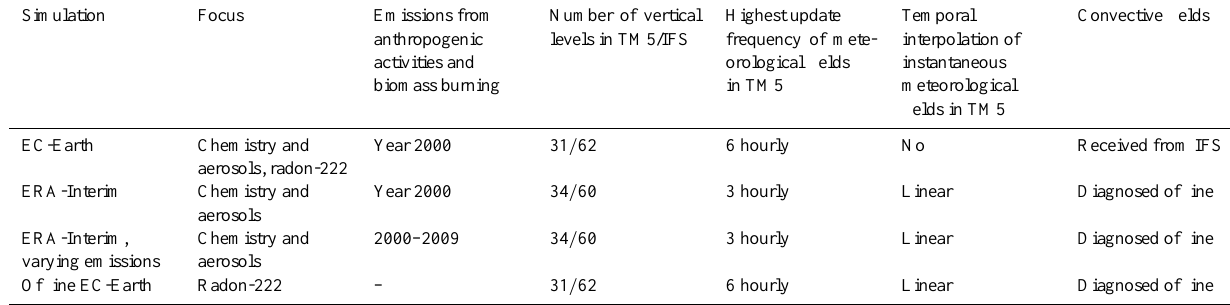
Table 2. Overview of the decadal simulations used in this study. Simulation Focus Emissions from